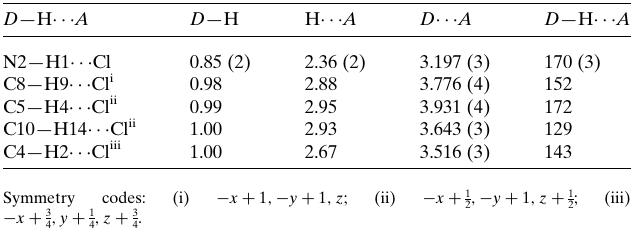
Table 1 Hydrogen-bond geometry (A˚ , (cid:5) ) for 3 .